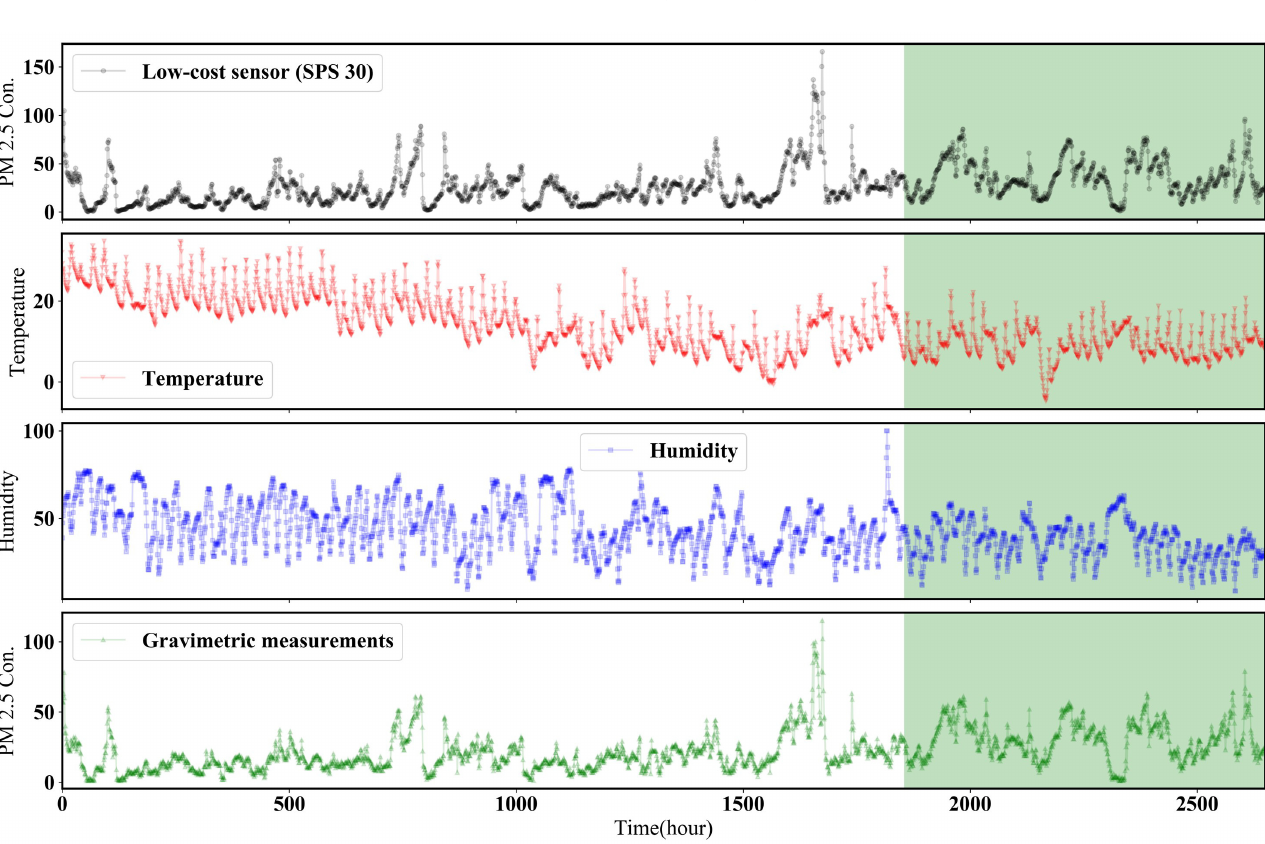
Figure 4. Results of collected dataset. From top to bottom, PM 2.5 of SPS 30, temperature and humidity of SHT 85 and PM 2.5 of TEOM. The white box region represents the training set that is used to develop the calibration model. The green box region represents the test set that is used to evaluate the developed calibration models. The period of training set is